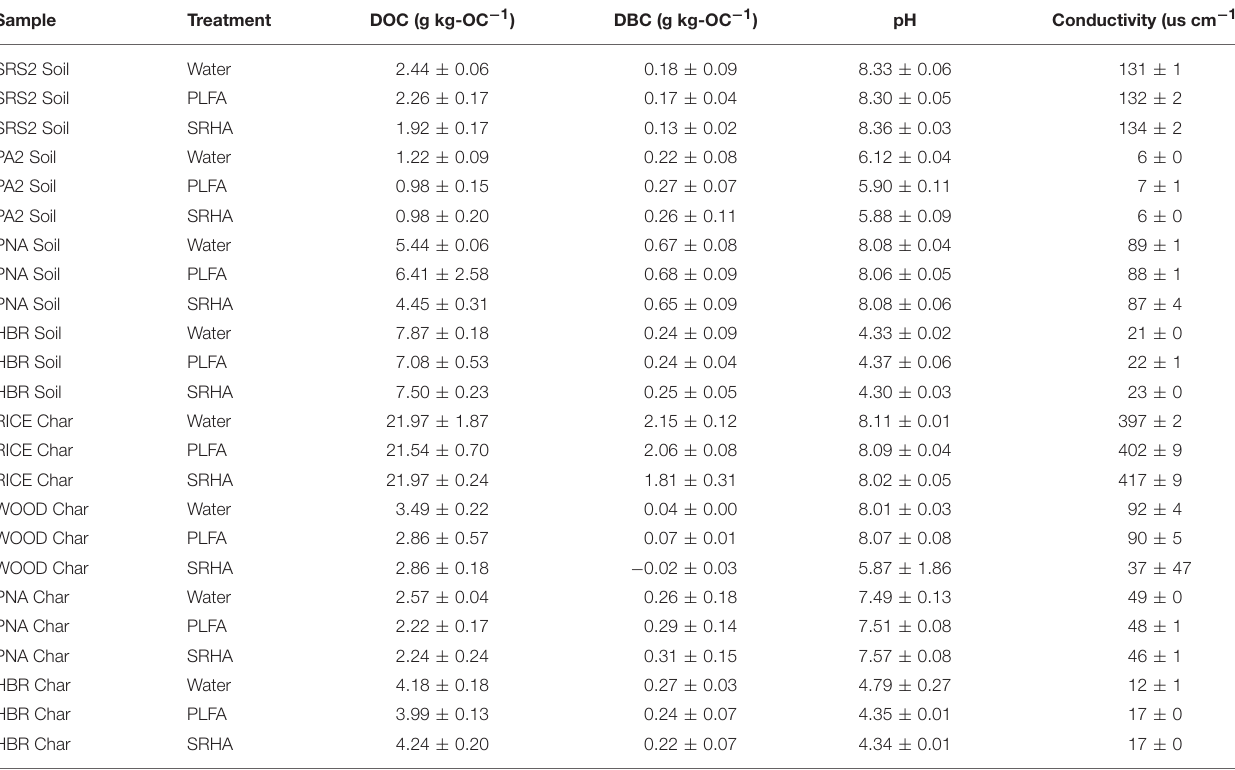
TABLE 2 | Experimental data for the DOM leached from soils and chars with deionized water, PLFA, and SRHA.